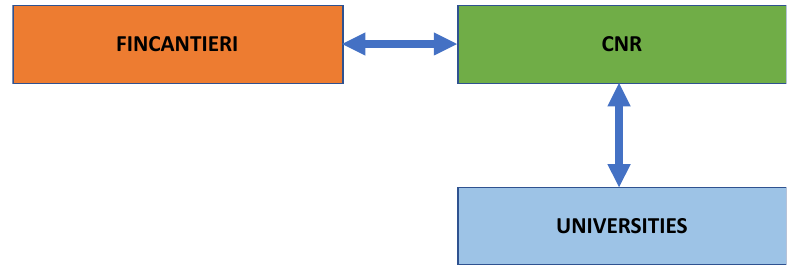
Figure 2. The hierarchy in the collaboration.